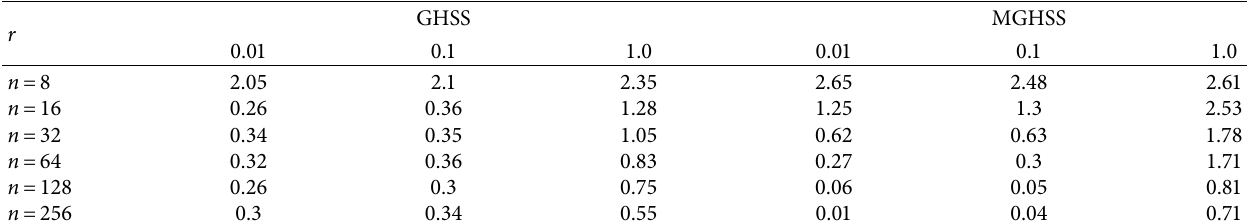
and β for GHSS and exp exp